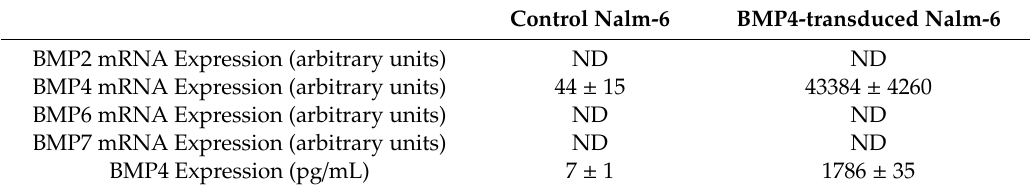
Table 2. Expression of Bone Morphogenetic Protein (BMP) ligands in acute lymphoblastic leukaemia (ALL) cell lines. Control Nalm-6 BMP4-transduced Nalm-6 BMP2 mRNA Expression (arbitrary